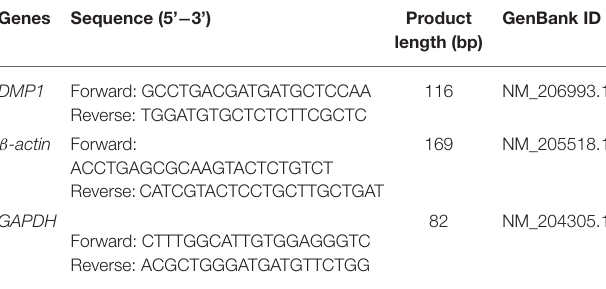
TABLE 2 | Primers used for the target and reference genes (experiments 2 and